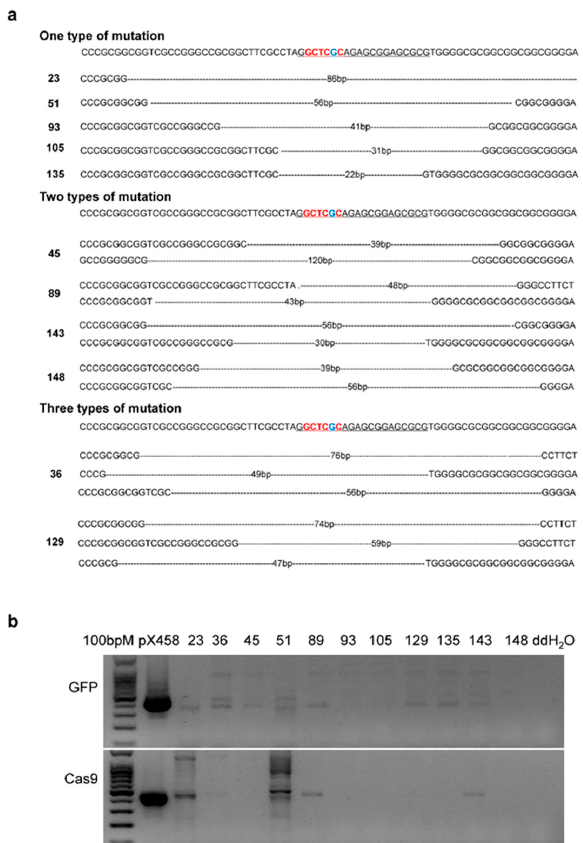
Figure 2. Identification of mutation types and detection of foreign DNA residues in homozygous mutant single-cell clones: ( a ) Identification of mutation types in homozygous mutant single-cell clones via TA clone sequencing. Bases in red represent the ZBED6-binding site, the base in blue represents the key base of the ZBED6-binding site, underlined bases indicate sgRNA, and dashed lines represent base deletion. ( b ) Detection of foreign DNA residues in homozygous mutant single- cell clones using PCR. The upper image shows the fragments amplified from homozygous mutant single-cell clones using primers designed based on the GFP gene; the lower image shows the frag- ments amplified from homozygous mutant single-cell clones using primers designed based on the Cas9 gene.